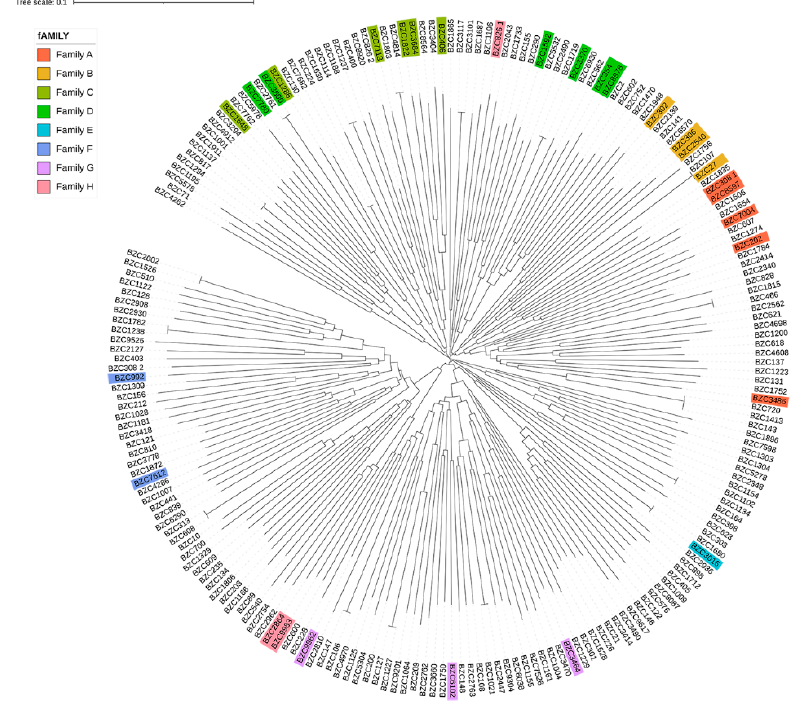
Figure 3. Phylogenetic tree of all individuals in this population. Individuals with the same color belong to the same familial lineage.